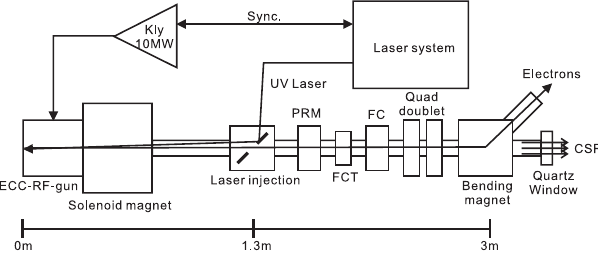
FIG. 11. Experimental setup for the ECC-rf